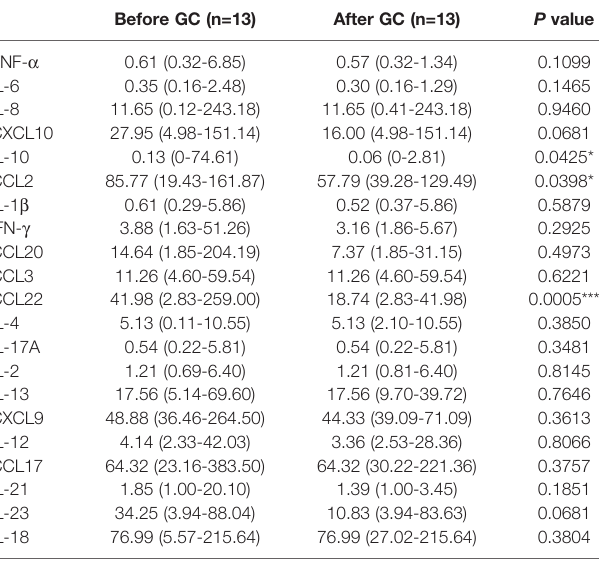
Cytokineconcentrationsareexpressedinpg/mlasmedian(min-max).Datawereanalyzed by Wilcoxon test; *P < 0.05; ***P <